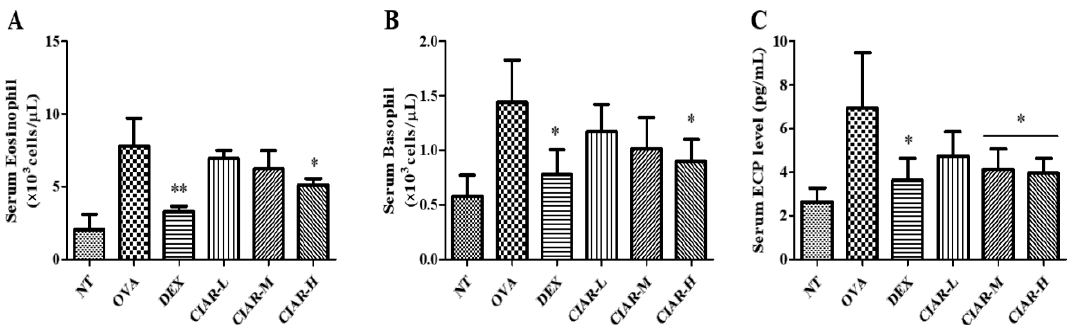
Figure 1. Effects of CIAR on immune cell composition, ( A ) eosinophil and ( B ) basophil population ( × 10 3 cells/μL), and ( C ) ECP (eosinophil cation protein) level in blood of mice with ovalbumin-in- duced allergic rhinitis. Data are shown as the mean ± SE. Significant differences are indicated as *